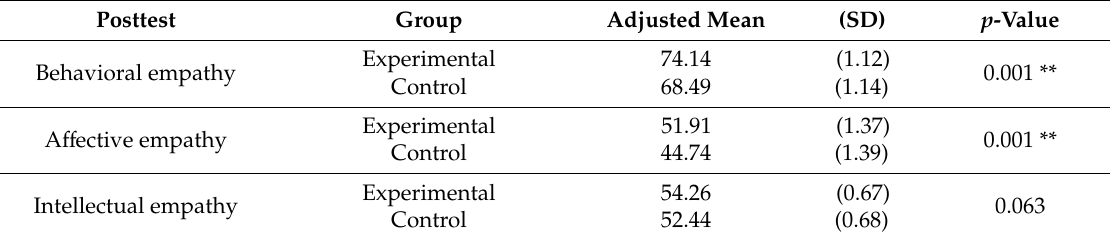
Table 8. MANCOVA and the adjusted posttest means for the